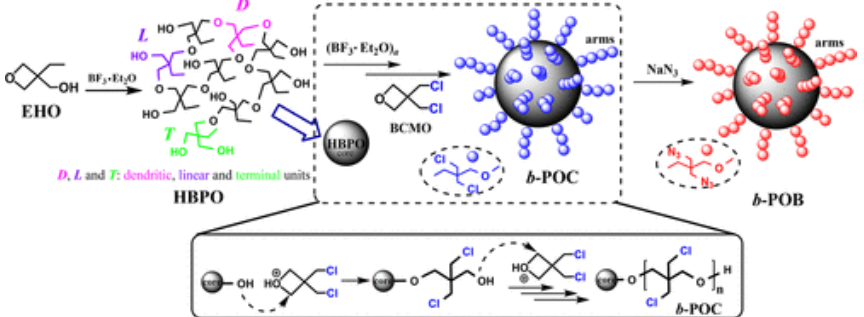
Figure 7. Schematic synthetic route of b-POB. Reprinted with permission from [31]. Copyright 2022 American Chemical